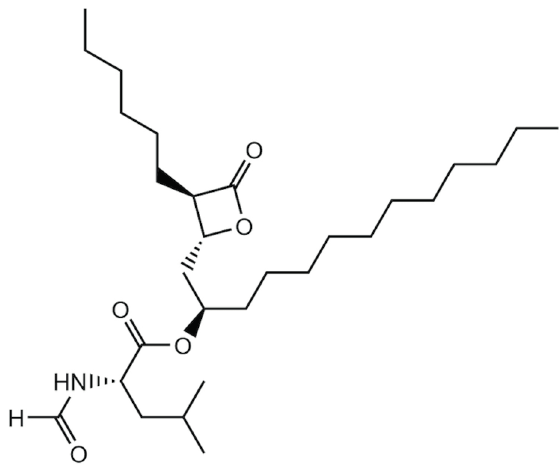
Figure 1. Chemical structure of orlistat (ChemDraw Professional ®